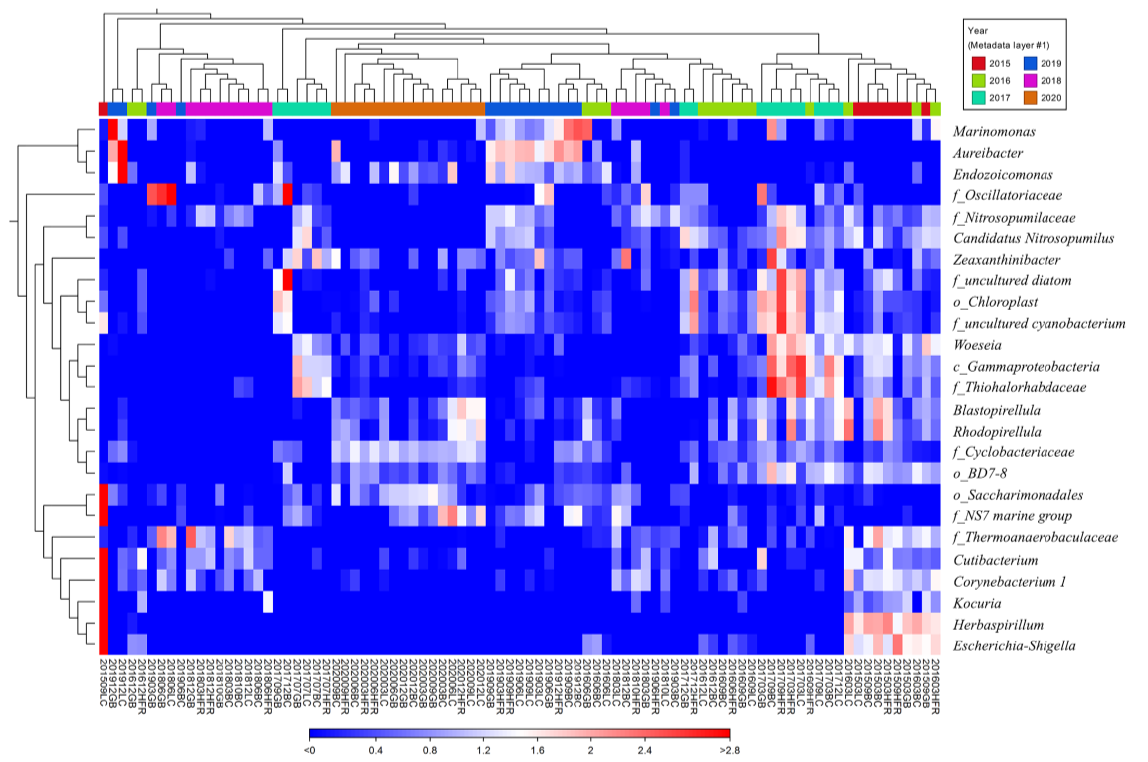
Figure 3. Heat map of the relative abundance of the 25 genera with highest coefficients of variation. Clusters based on microbial community composition are above the heat map; clusters based on the genera are on the left of the heat map. The data were scaled per column. The values represent the relative abundance of genera in the sample.